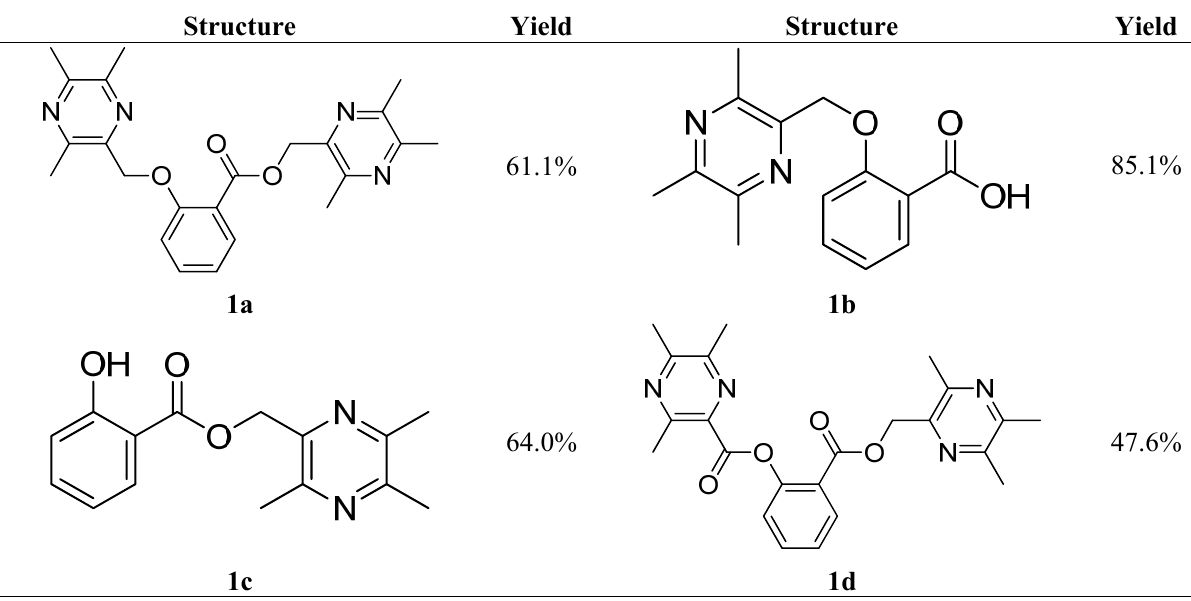
Table 1. The structures of ligustrazine-benzoic acid